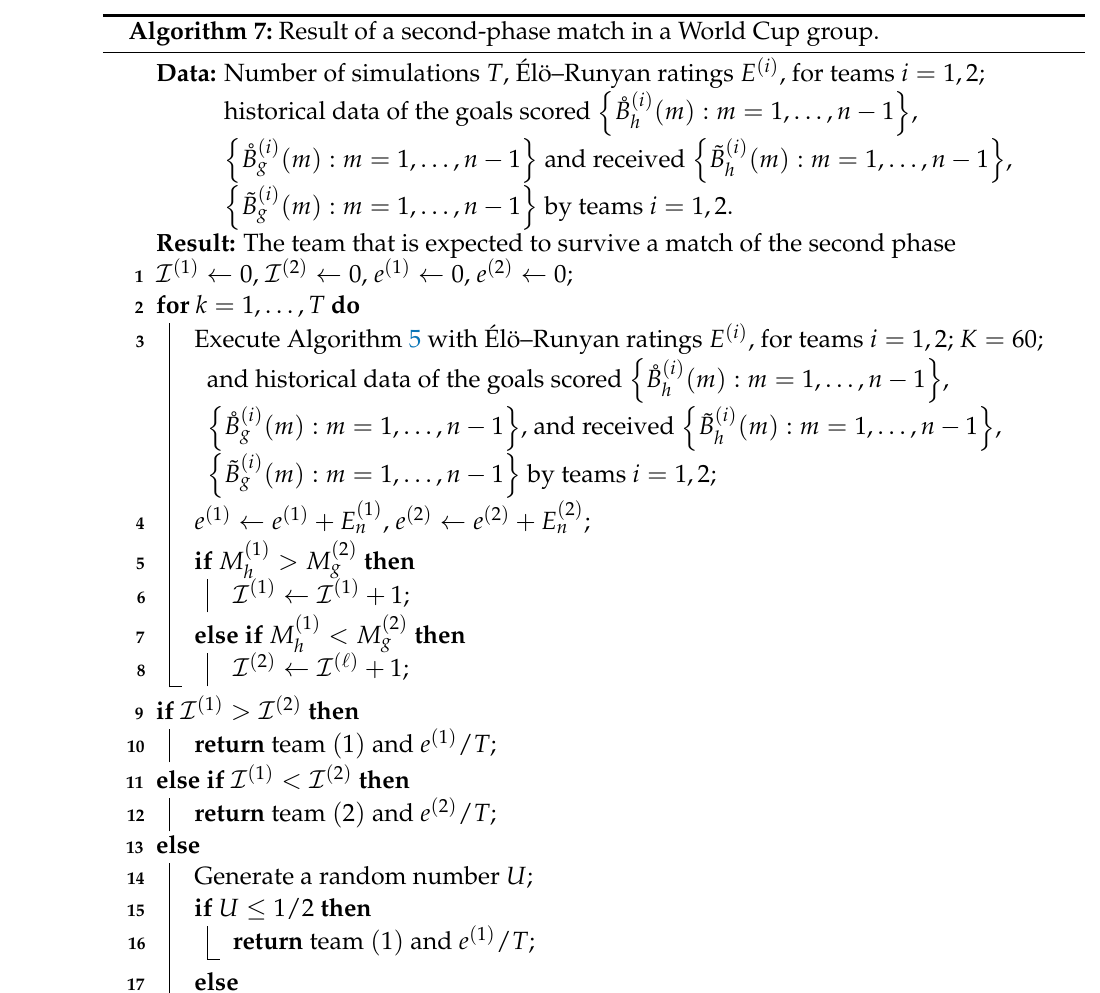
Algorithm 7: Result of a second-phase match in a World Cup